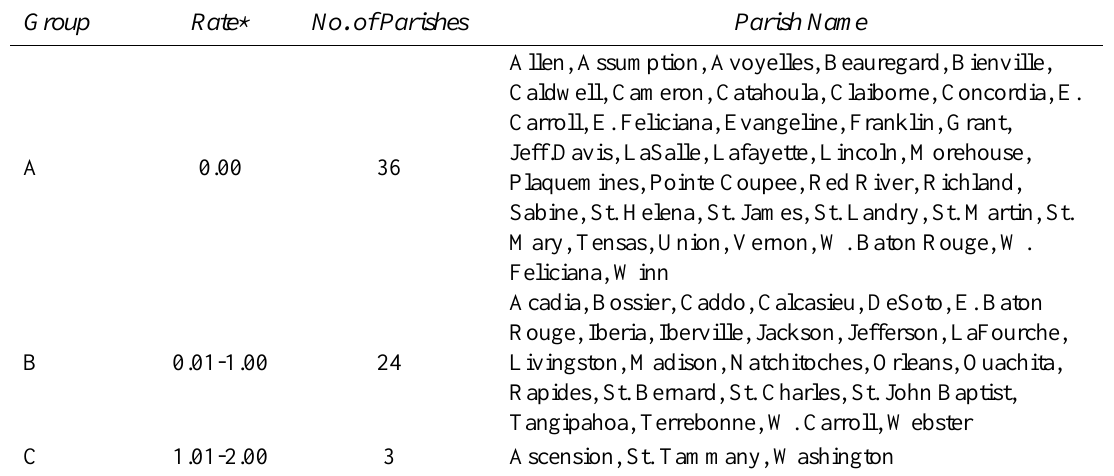
Table 10: Distribution of shigella in various parishes for the year